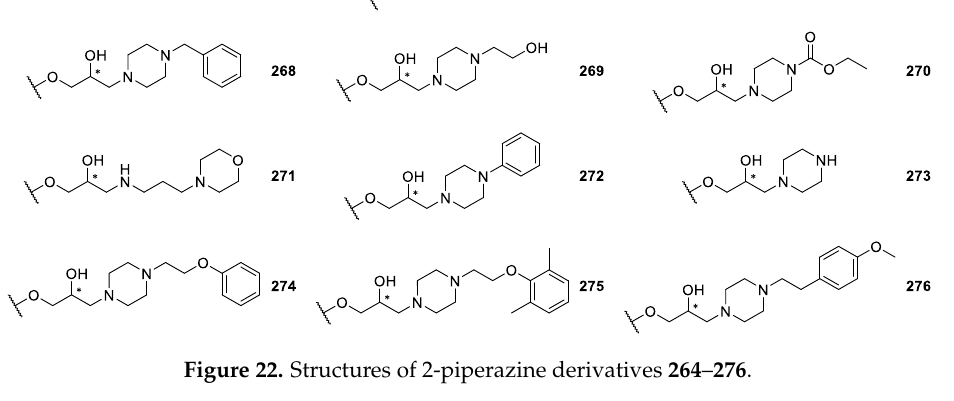
Figure 22. Structures of 2-piperazine derivatives 264 – 276 .